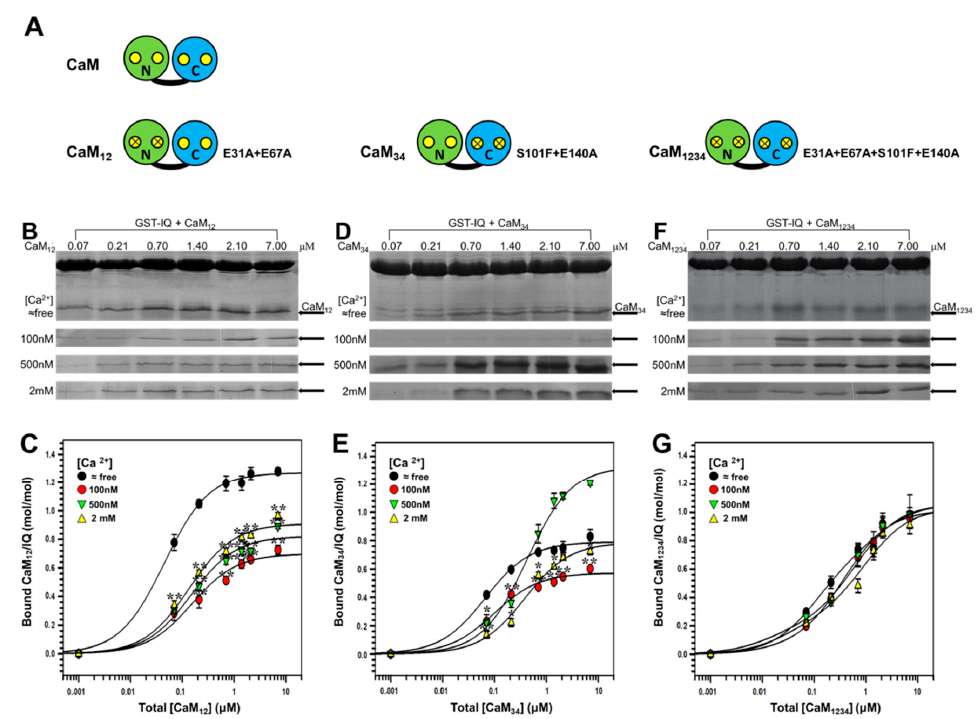
Figure 3. Interaction of CaM and its mutants (CaM 12 /CaM 34 /CaM 1234 ) with Na V 1.1 IQ domain by pull-down assay. ( A ) Schematic illustrations of CaM and its mutant CaM 12 , CaM 34 , CaM 1234 . Yellow circles represent normal Ca 2+ -binding sites on N/C-lobe. Yellow circles with X on it represent neutralized Ca 2+ -binding sites. Amino acid mutations are shown with red letter code. ( B , D , F ) GST pull-down assay for the binding of CaM 12 ( B )/CaM 34 ( D )/CaM 1234 ( F ) to IQ. GST-fusion IQ was incubated with increasing concentrations of CaM 12 /CaM 34 /CaM 1234 (0.07–7 μ m) at fixed [Ca 2+ ] of ≈ free, 100 nM, 500 nM, and 2 mM. Protein bands were stained by Coomassie Brilliant Blue. CaM 12 /CaM 34 /CaM 1234 protein bands are pointed out by arrows. ( C , E , G ) Bound CaM 12 ( C )/CaM 34 ( E )/CaM 1234 ( G ) are plotted against total [CaM 12 ]/[CaM 34 ]/[CaM 1234 ] on a molar ratio (CaM 12 or CaM 34 or CaM 1234 /GST-IQ) basis with mean ± S.E. ( n = 4 for CaM 12 /CaM 34 /CaM 1234 ).* p < 0.05, ** p < 0.01, compared with corresponding bindings at Ca 2+ -free conditions.